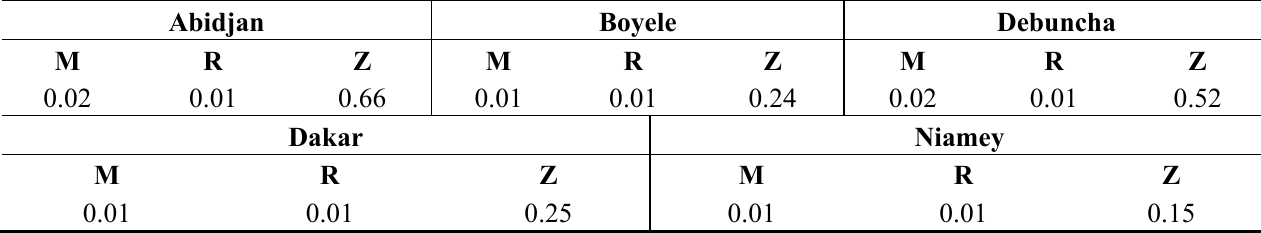
Table 6. RMSE between values measured by the disdrometer and those estimated by the PANN.